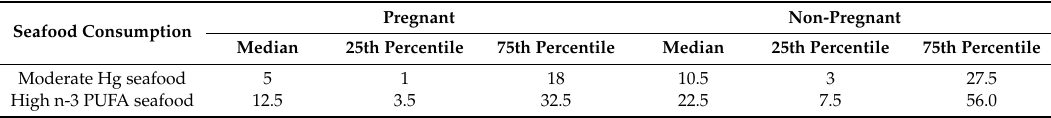
Table 2. Comparison of reported seafood consumption of seafood containing mercury, n-3 PUFA between pregnant and nonpregnant women in ounces consumed per month